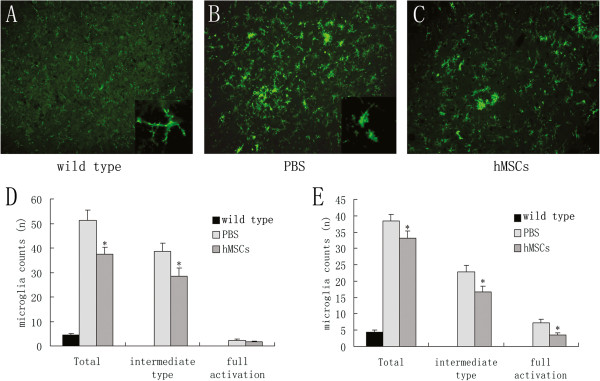
Inhibition of microglial activation by human marrow stromal cell treatment in SOD1 transgenic mice. Activation of microglia were detected by CD11b immunoreactivity in the spinal cord ventral gray of wild-type mice (A), PBS-treated transgenic mice (B), and human marrow stromal cell (hMSC)-treated transgenic mice (C) at the age of 15 weeks at 400× magnification. Higher-magnification images are shown in the insert for resting microglia (A) and activated microglia (B). Quantitative cell counts of CD11b-positive microglia in the ventral gray of mice at 11 weeks of age (D) and 15 weeks of age (E). Intrathecally injected hMSCs significantly suppressed microglial activation in Cu/Zn superoxide dismutase 1 (SOD1) transgenic mice (*P <0.01 versus PBS alone).